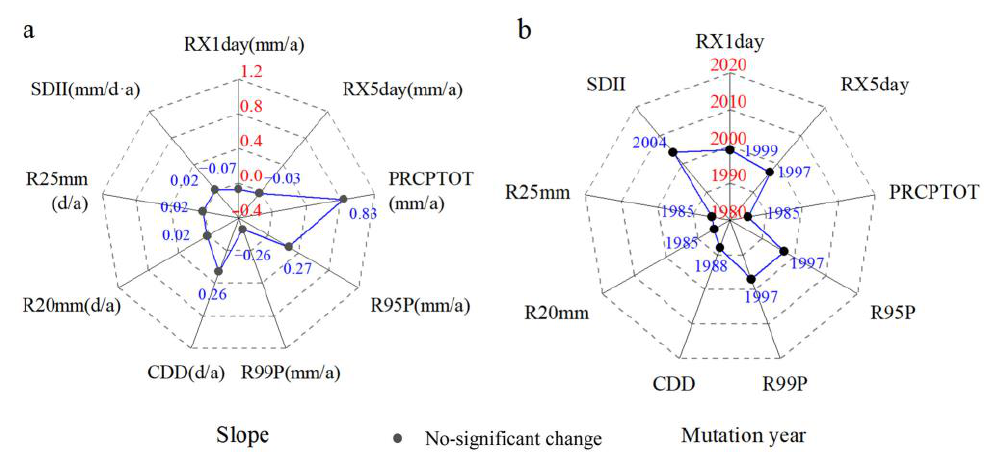
Figure 2. Trends ( a ) and abrupt years ( b ) of extreme precipitation indices in the Beijing–Tianjin–Hebei region from 1980 to 2019 (confidence level